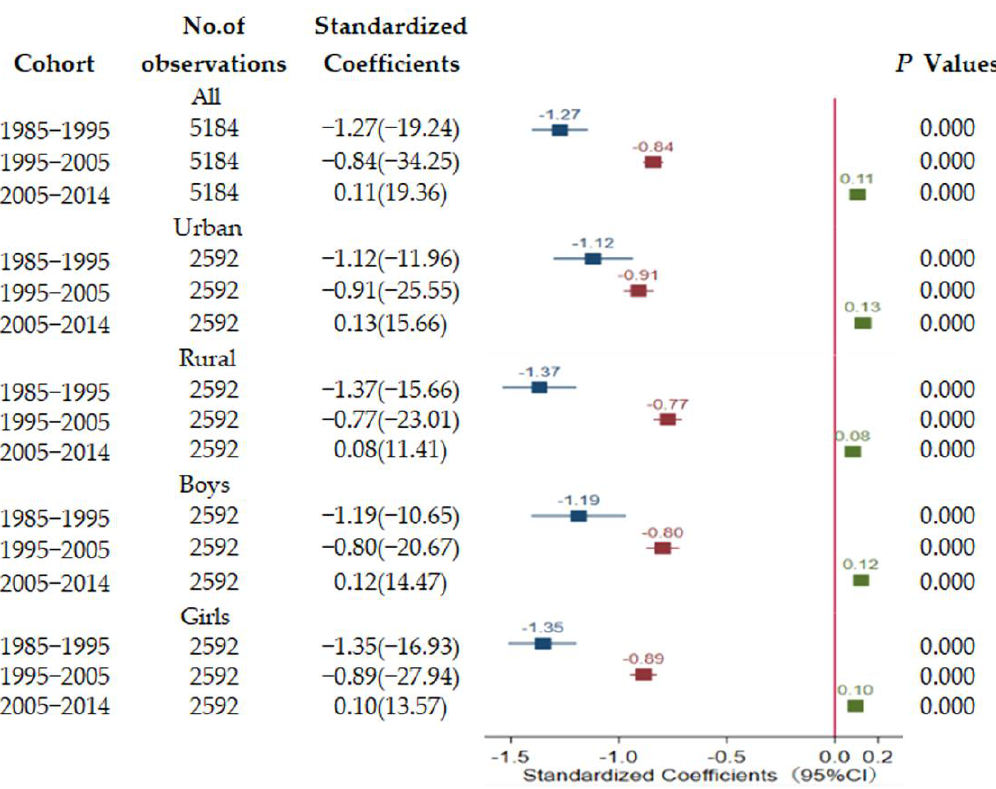
Figure 4. Longitudinal association of per capital GDP with lung function.